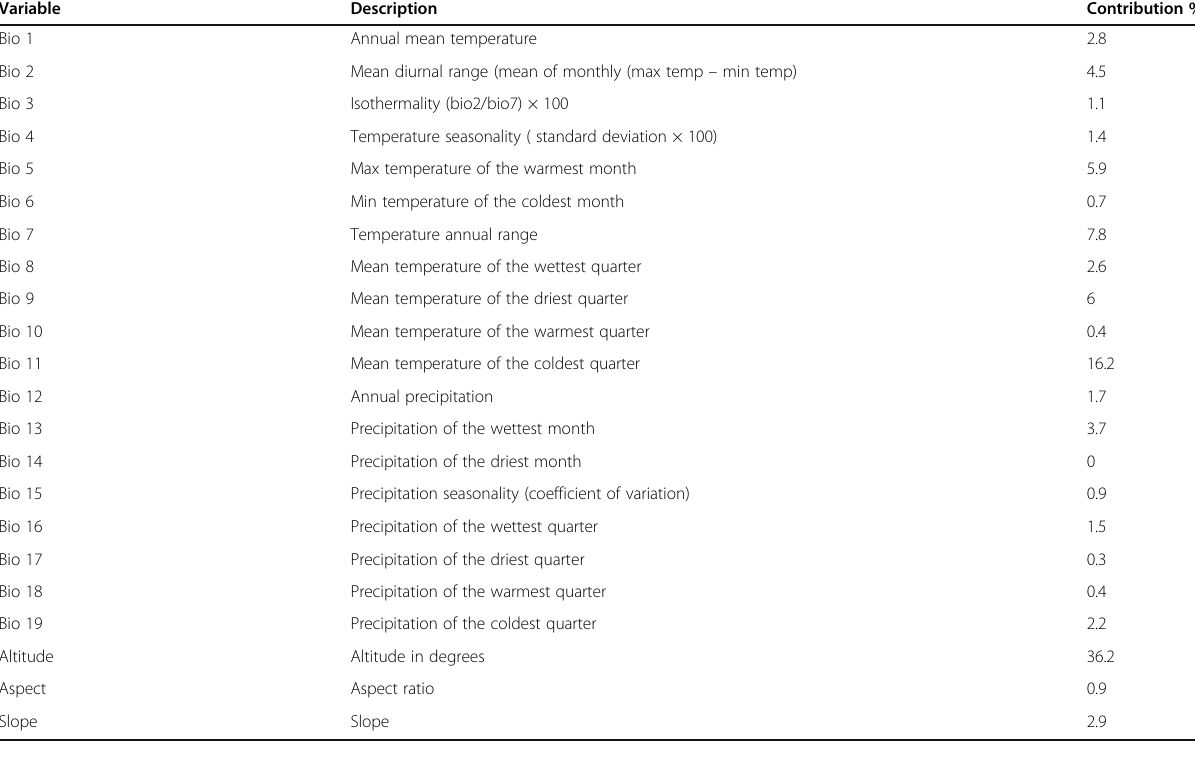
Table 4 The contribution percentage of the total 22 ecological and topographic layers in predicting the spatial distribution of Mantodea species in Egypt